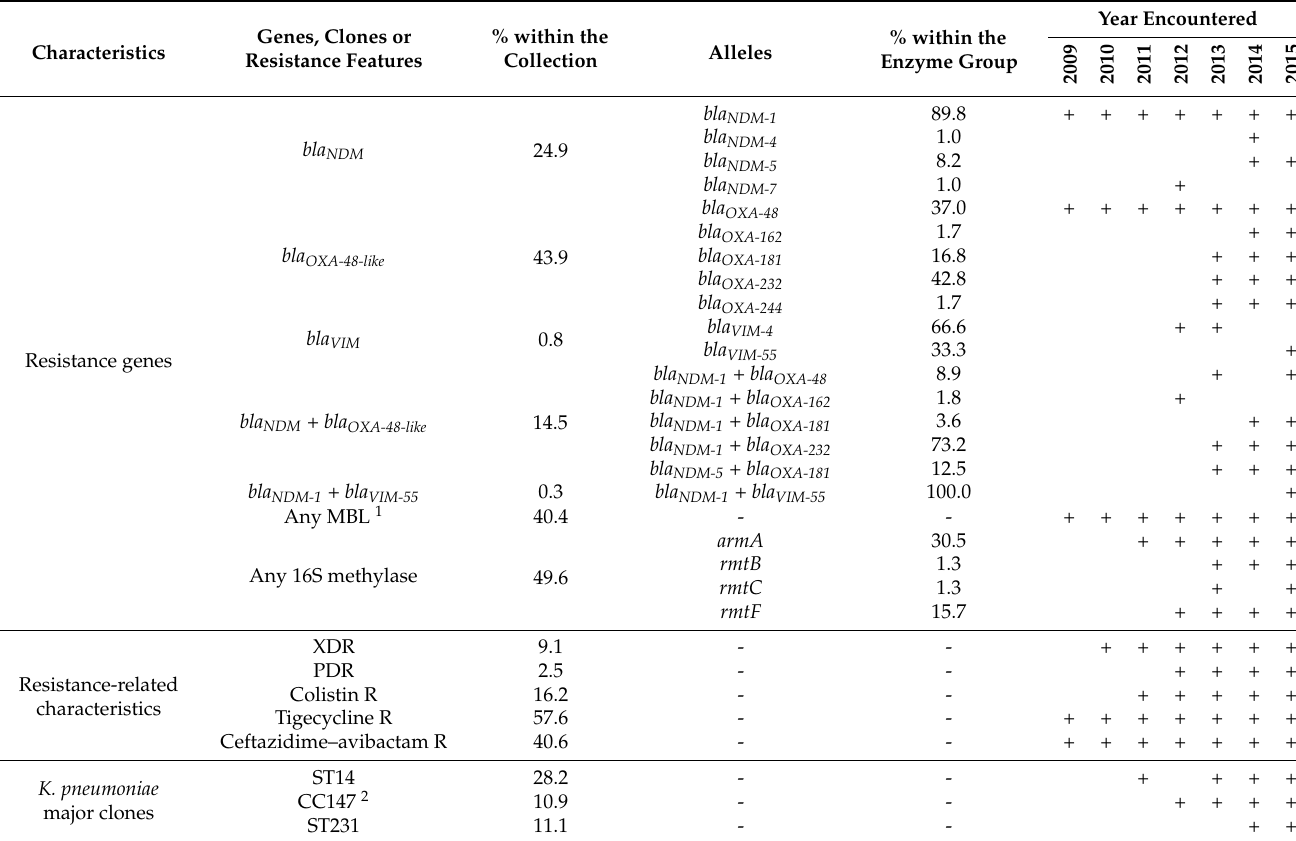
Table 1. Frequency and yearly presence of resistance genes, their alleles, clones, and certain resistance- related characteristics.